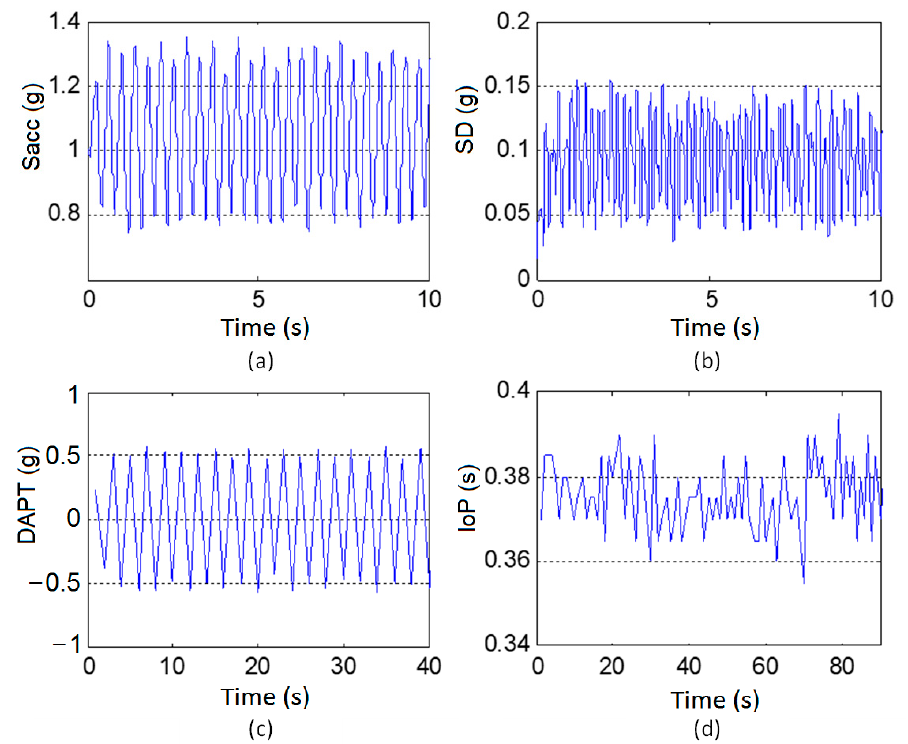
Figure 8. Diagram of features in D03: ( a ) Sacc over time; ( b ) SD over time; ( c ) DAPT over time; ( d ) IoP over time.